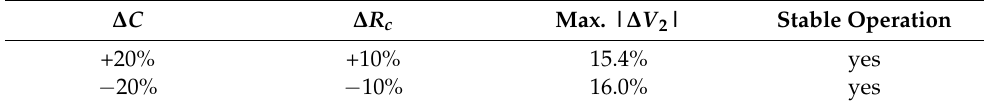
Table 8. Results of robustness analysis against variations of C and R c in Scenario #2.